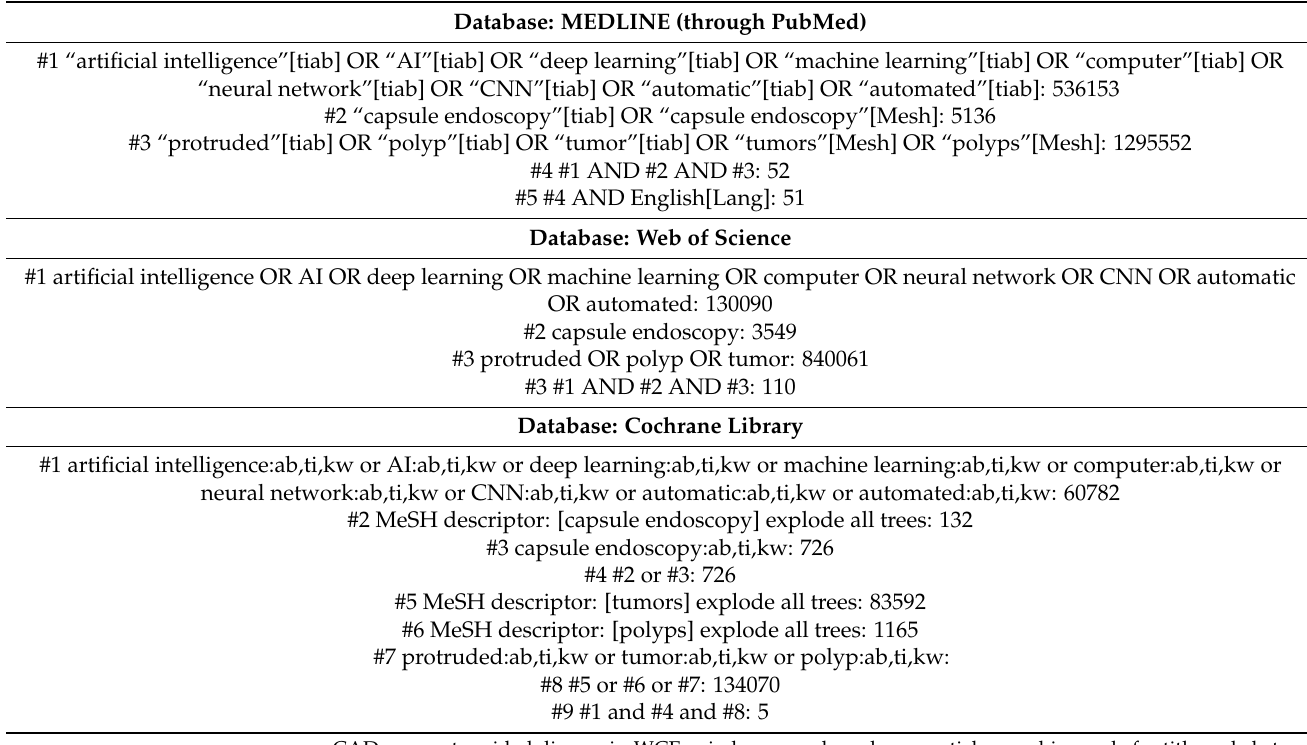
Table 1. Literature searching